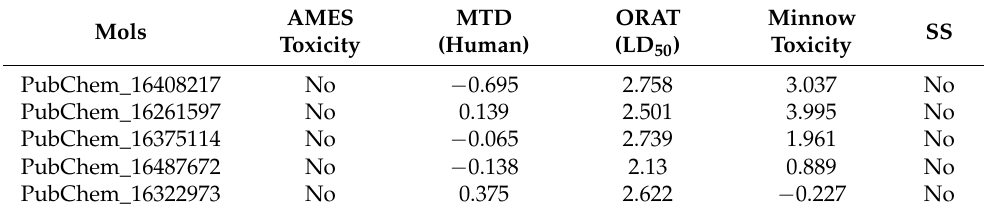
Table 3. Toxicity assessment of proposed CYP3A5